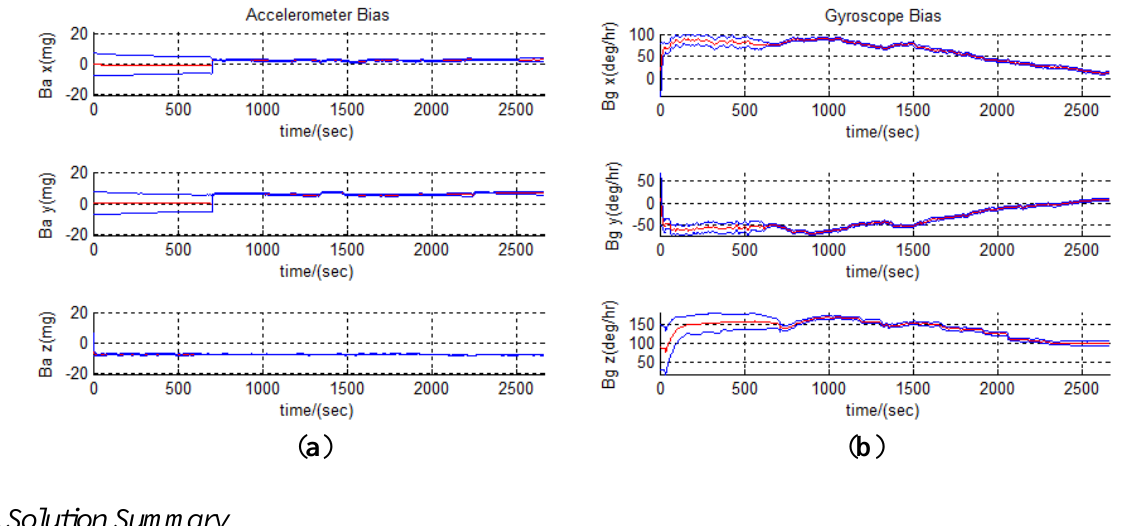
Figure 12. The IMU biases with IMU800CA (3-sigma envelope accuracy in blue). ( a ) Accelerometer Biases. ( b ) Gyroscope Biases.